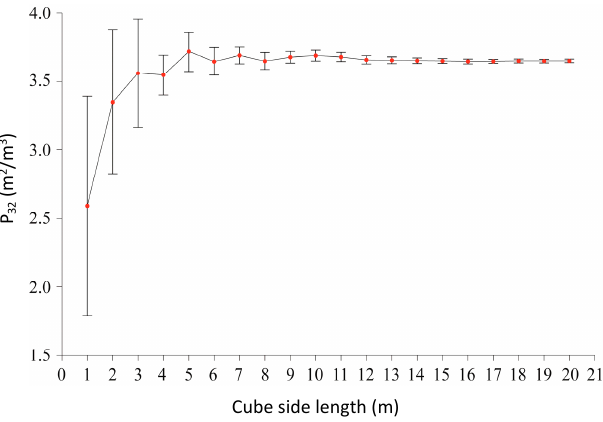
Figure 10. The error bar chart with confidence interval for different data sets.